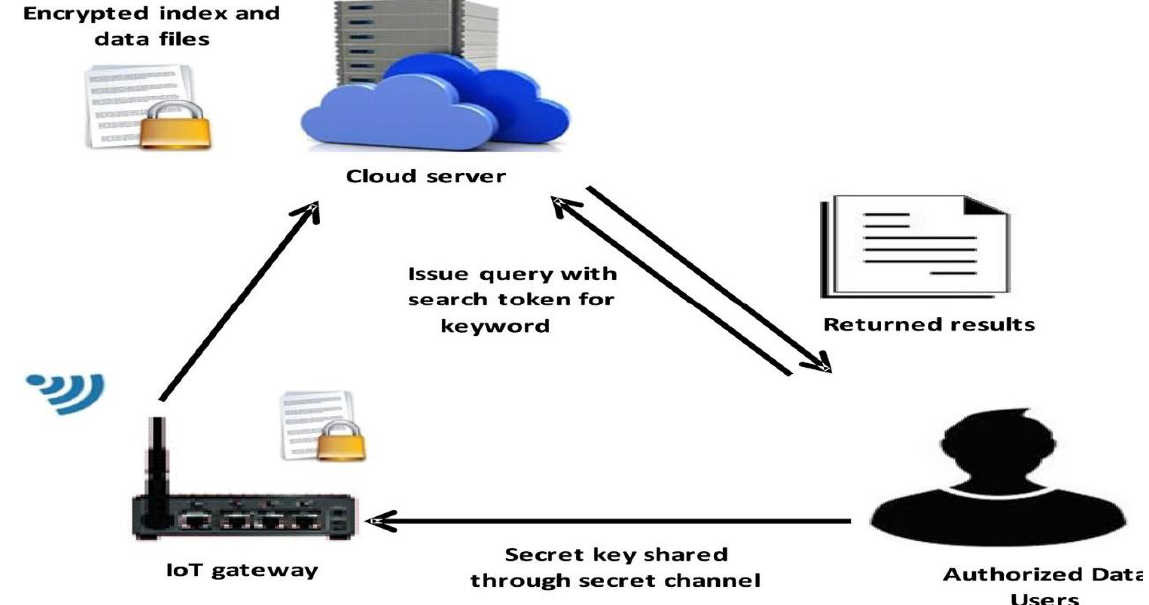
Figure 7 . Encryption for Cloud